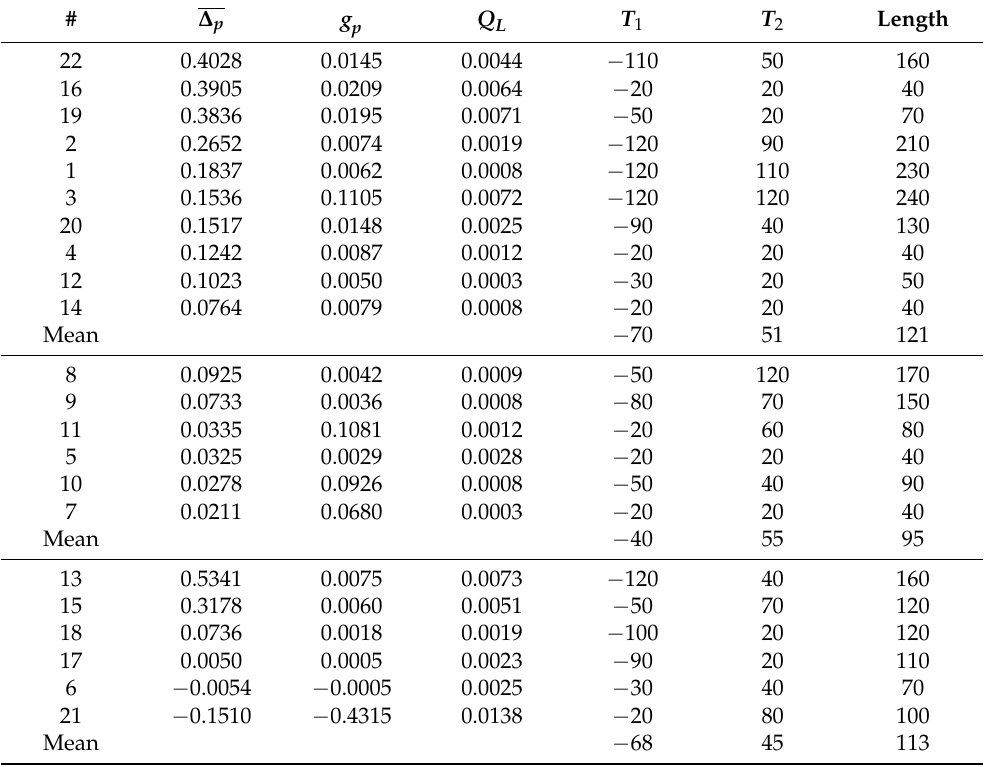
Table 4. Three different groups to classify all 22